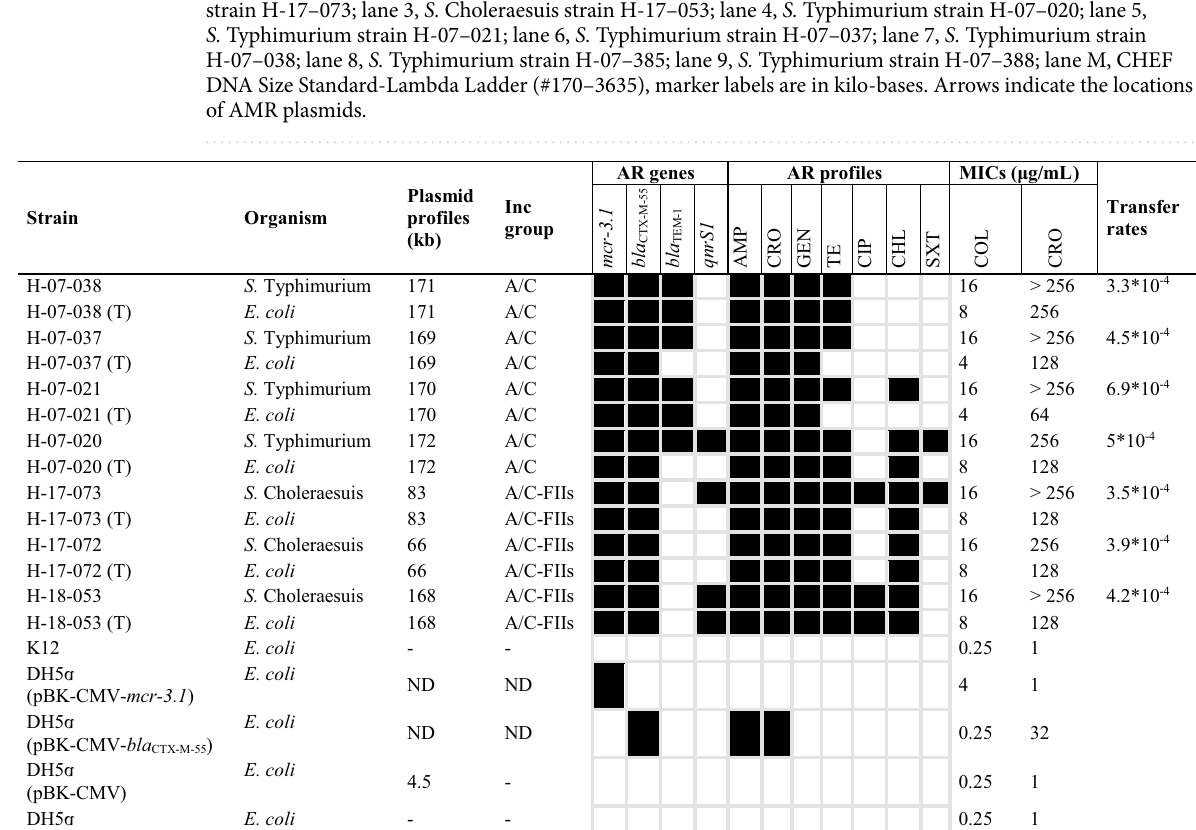
Table 1. Characterisation of seven Salmonella isolates co-carrying mcr-3.1 and bla CTX-M-55 genes, and the corresponding transconjugants and transformants. The alphabet letter (T) represents the corresponding transconjugants. Black squares represent the isolates as being resistant to the indicated antimicrobial agents. AMP ampicillin, CRO ceftriaxone, GEN gentamicin, TE tetracycline, CIP ciprofloxacin, CHL chloramphenicol, SXT trimethoprim-sulfamethoxazole, COL colistin, ND not determined, - not